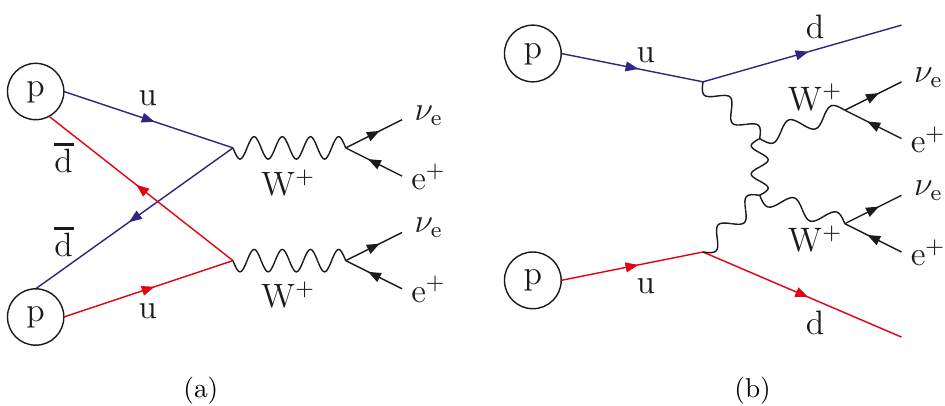
Figure 1 . Production of a W + W + pair at a pp collider: (a) via DPS, (b) via SPS. More Feynman diagrams participate in the SPS process but they are not represented here. Both SPS and DPS contribute to the total cross section for same-sign WW